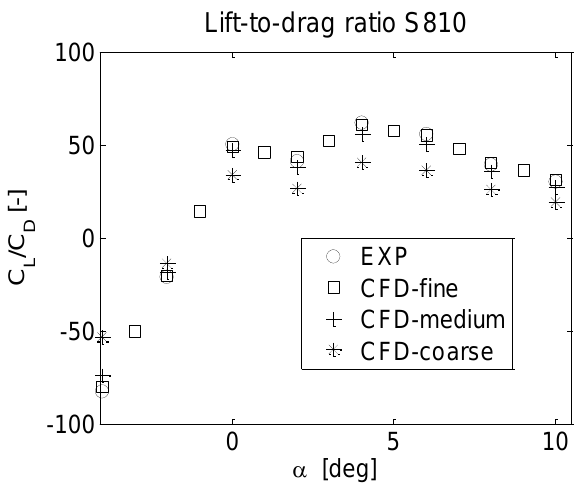
Figure 3. Lift-to-drag ratio of the numerical simulations versus experimental data of the clean airfoil s810 without any flow control device. CFD: computational fluid dynamics.